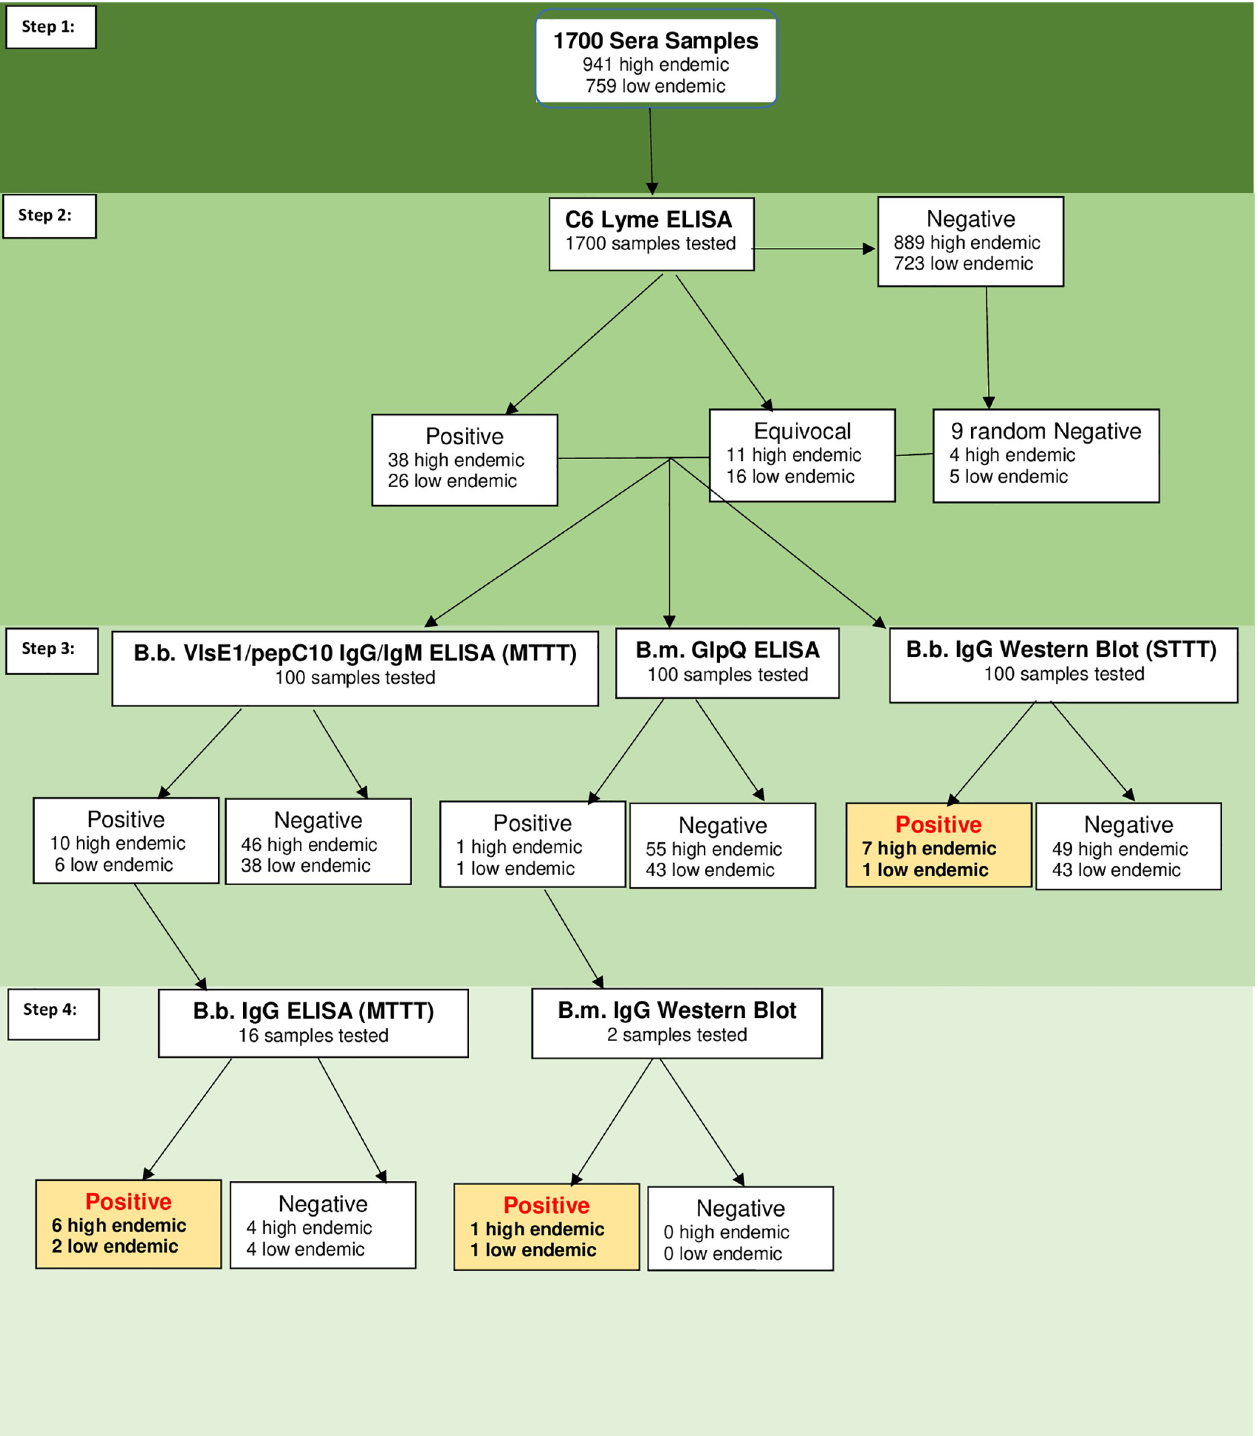
Fig 2. Flowchart of testing strategies. Testing strategy followed for the 1,700 blood donors from California. Each step of the diagram details the testing strategy and the number of samples tested.